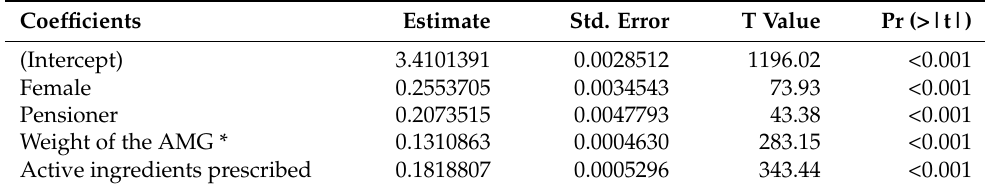
Table 5. Relationship between costs and most significant explanatory